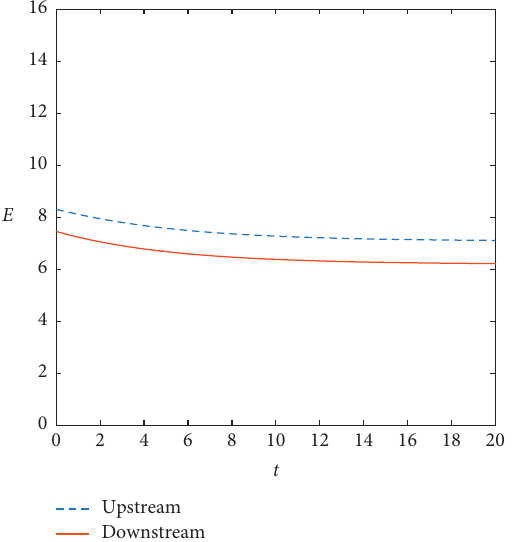
Figure 7: Optimal trajectory of pollution abatement investment under non-cooperation when T � 10.